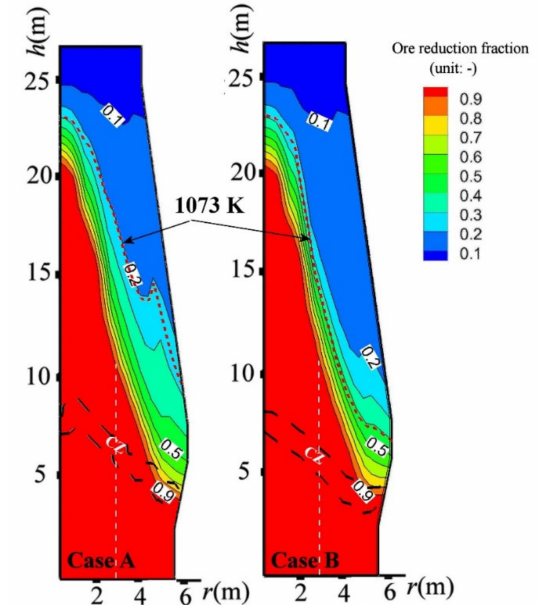
Figure 8. Profiles of ore reduction fraction in cases A and B.